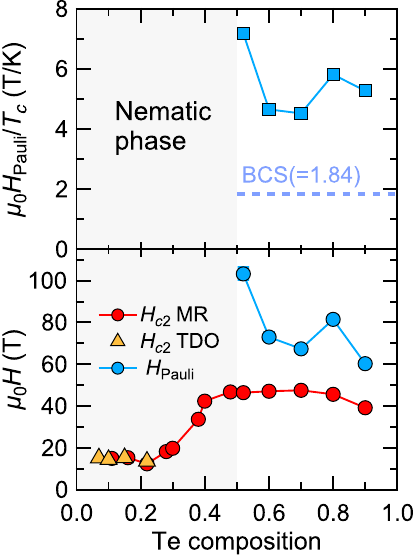
FIG. 4. Te composition x dependence of the upper critical field in FeSe 1 − Te . The bottom panel displays H at the lowest x x c 2 temperature determined by the resistance (red circles) and TDO (yellow triangles) measurements, and the Pauli-limited field H (blue circles) estimated as mentioned in the main text. Pauli The top panel shows H (blue squares) divided by their critical Pauli temperature T . The dashed line indicates the value predicted in c weak-coupling BCS theory. The gray shades represent the compositions where nematic phase